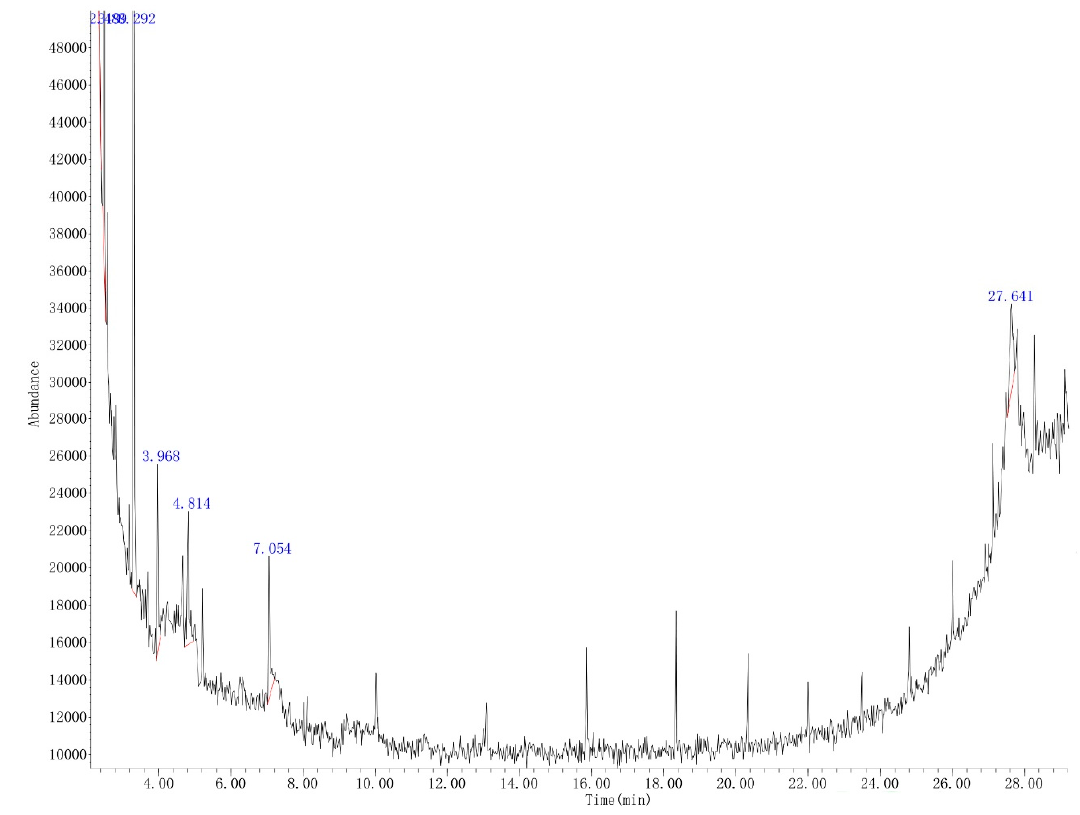
Figure 6. TIC of unregulated emissions absorbed by absorption liquid in PPCI. Table 6. Exhaust components absorbed by absorption liquid in PPCI.